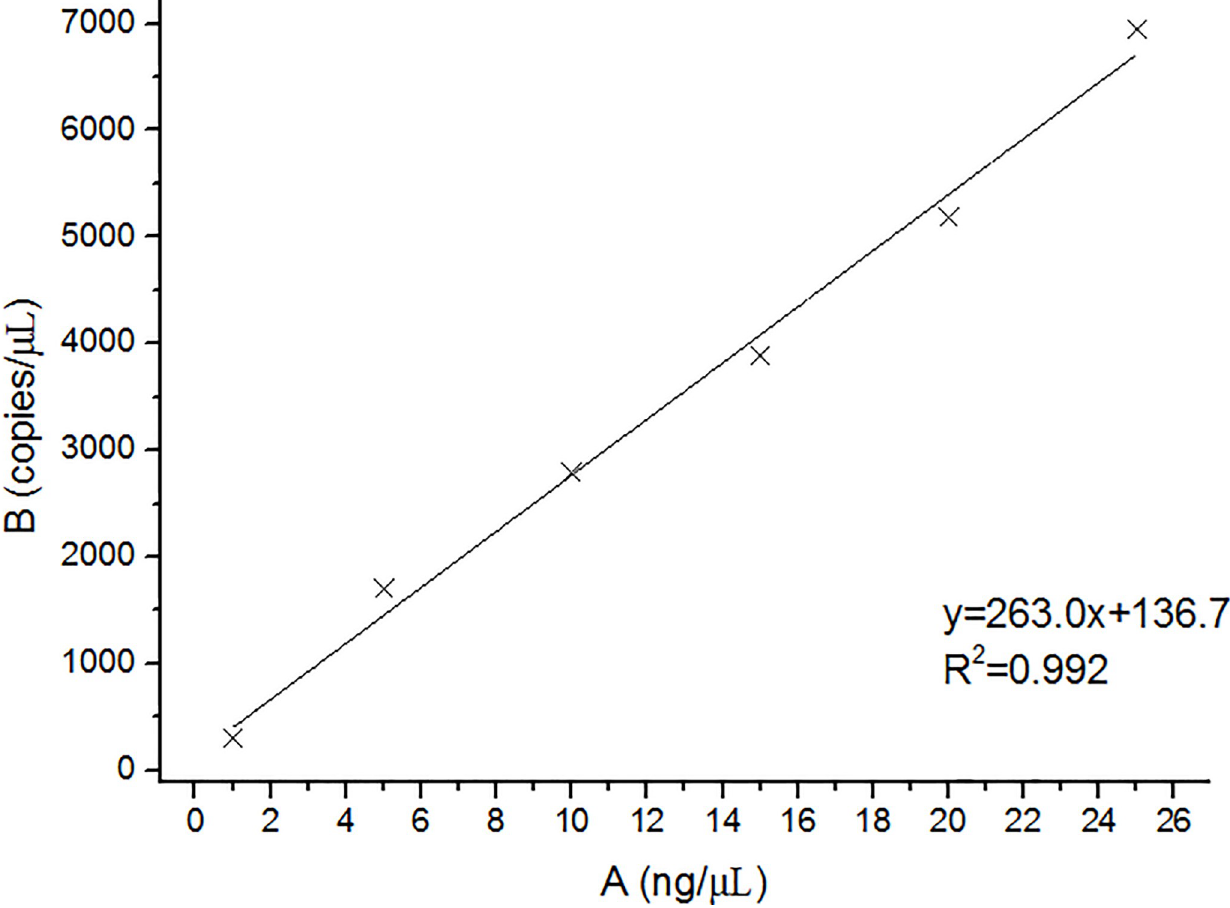
Fig 4. Relationship between cassava DNA content and copy number.